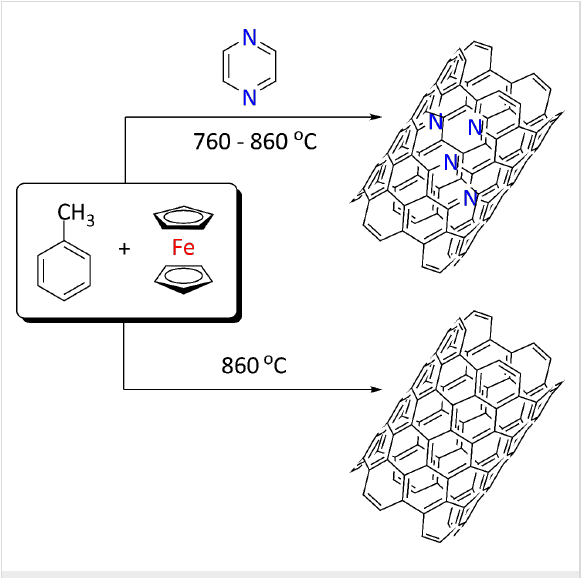
Scheme 1: Schematic reactions in the synthesis of N-CNTs and MWCNTs; for clarity only the outer nanotube walls are shown.